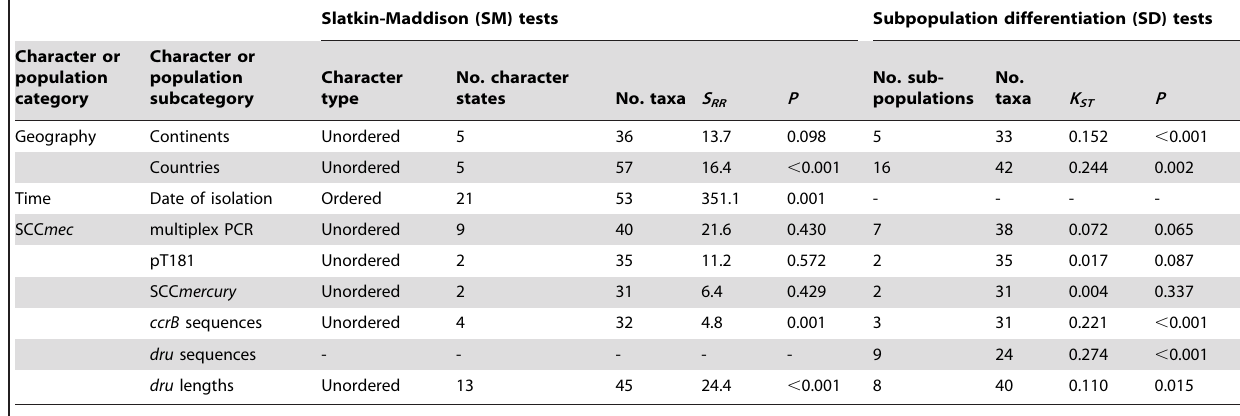
Table 2. Analyses of population structure using clone-corrected